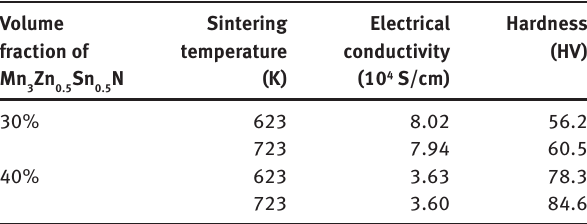
Table 2: The average electrical conductivity and Vickers hardness of Mn Zn Sn N/Al composites. 3 0.5 0.5 Volume fraction of